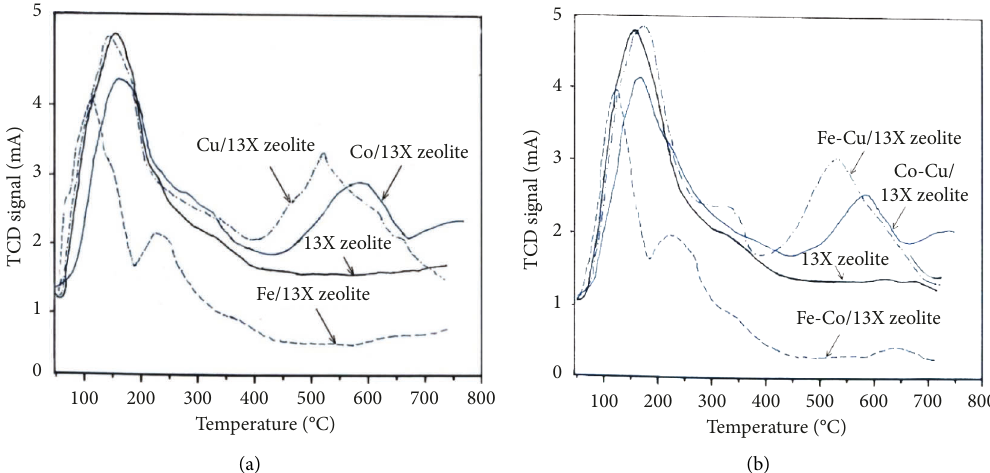
Figure 7: TPD-NH 3 profiles of (a): 13X zeolite; Fe/13X zeolite; Co/13X zeolite; Cu/13X zeolite; and (b): 13X zeolite Fe-Co/13X zeolite; (f) Fe-Cu/13X zeolite; (g) Co-Cu/13X